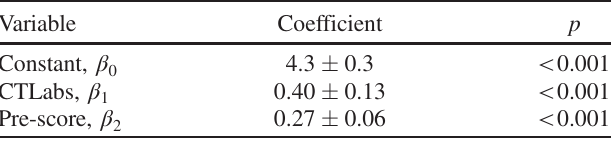
TABLE XIV. Linear model for PLIC postscore as a function of lab treatment and prescore using the imputed